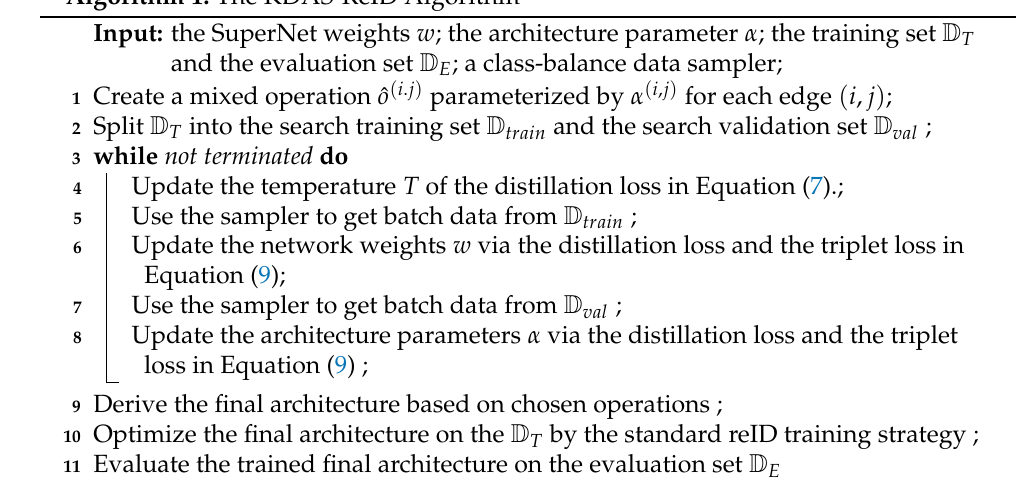
Algorithm 1: The KDAS-ReID